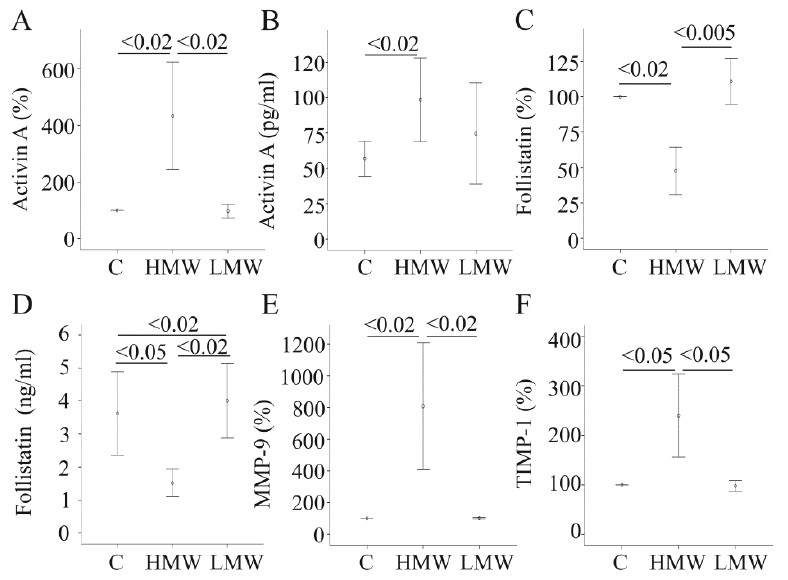
Figure 2. The effect of adiponectin (APN) isoforms on genes/proteins involved in fibrosis. ( A ) Activin A mRNA expression was determined in primary human hepatocytes (PHH) of four different donors, either cultivated in the presence of 10 µg/mL of HMW-APN or 2 µg/mL of LMW-APN for 24 h. ( B ) Activin A protein was measured by ELISA in the supernatants of cells described in (A); data of five experiments are shown. ( C ) Follistatin mRNA expression in the cells described in (A), data of four experiments are shown; ( D ) Follistatin protein was measured by ELISA in the supernatants of cells described in (A); data of three experiments are shown. ( E ) The expression of MMP-9 mRNA in the cells described in (A); data of four experiments are shown. ( F ) The expression of TIMP-1 mRNA in the cells described above; data of four experiments are shown. Data on mRNA expression are given as % of control cultivated cells. Numbers within the graphs indicate p